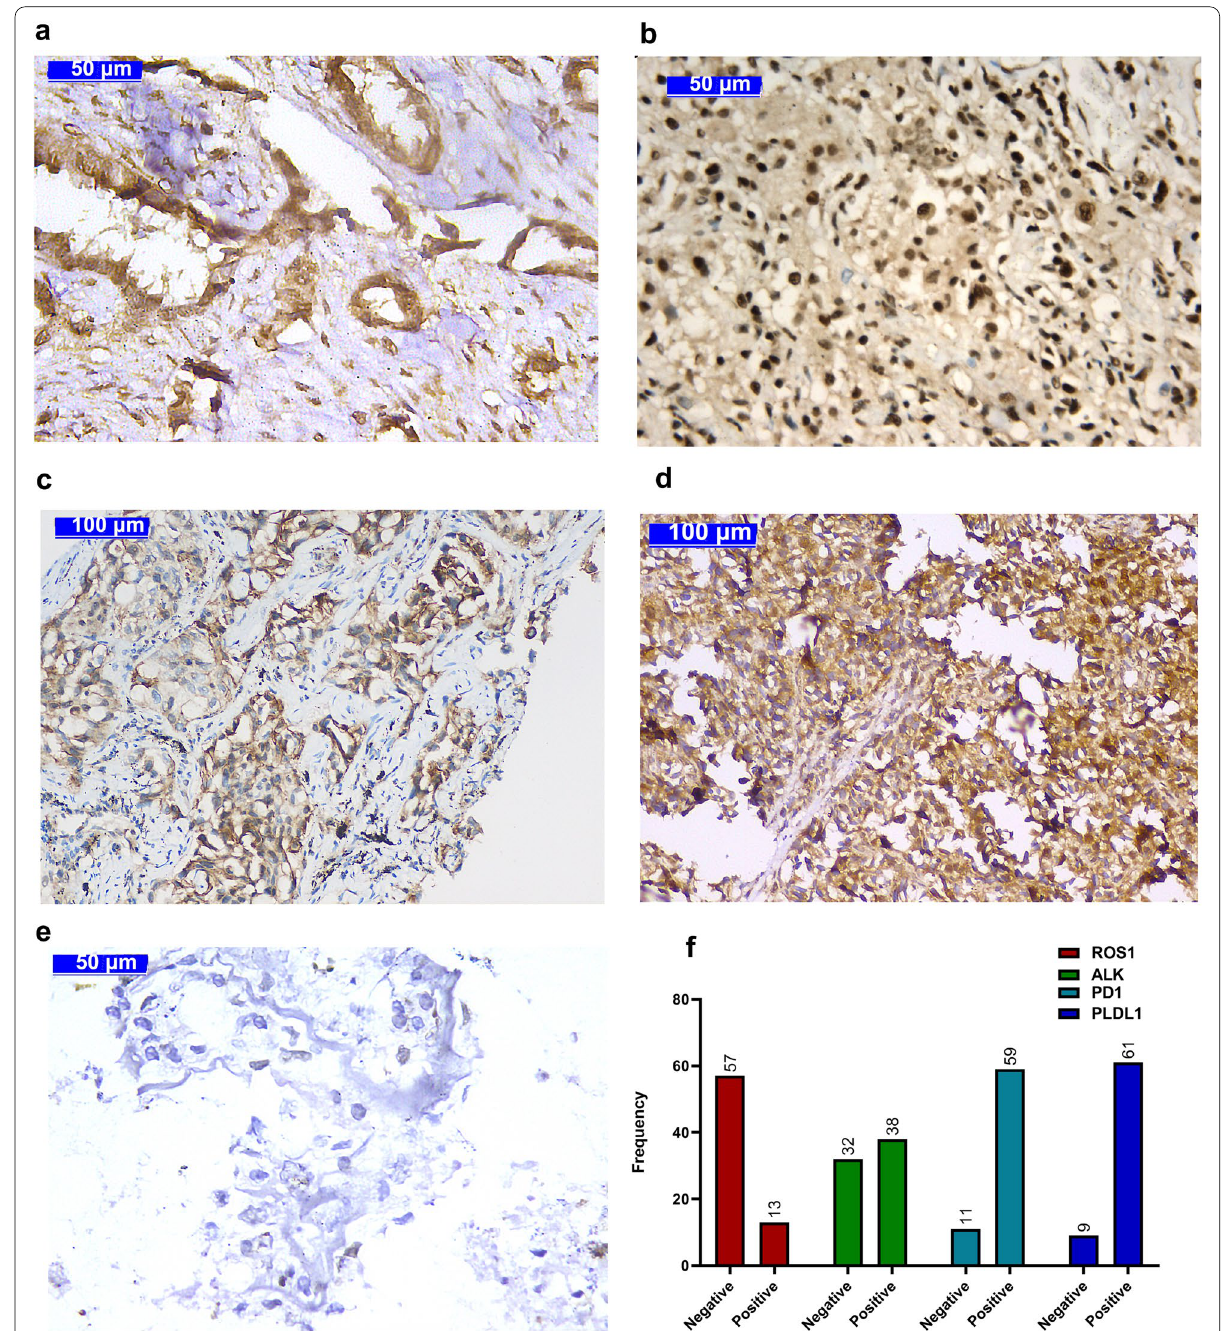
Fig. 1 Immunohistochemical staining of a ROS1 (40X), b ALK (40X), c PD‑1 (20X), and d PD‑L1 (20X) in adenocarcinoma specimens. e Negative immunohistochemical expression (40X). Majority of cells showed membranous staining for ROS1, nuclear and membranous staining for ALK, cytoplasmic and membranous staining for PD‑1 was and PD‑L1. f Bar plot showing the frequency of the ROS1, ALK, PD‑1, and PD‑L1 proteins